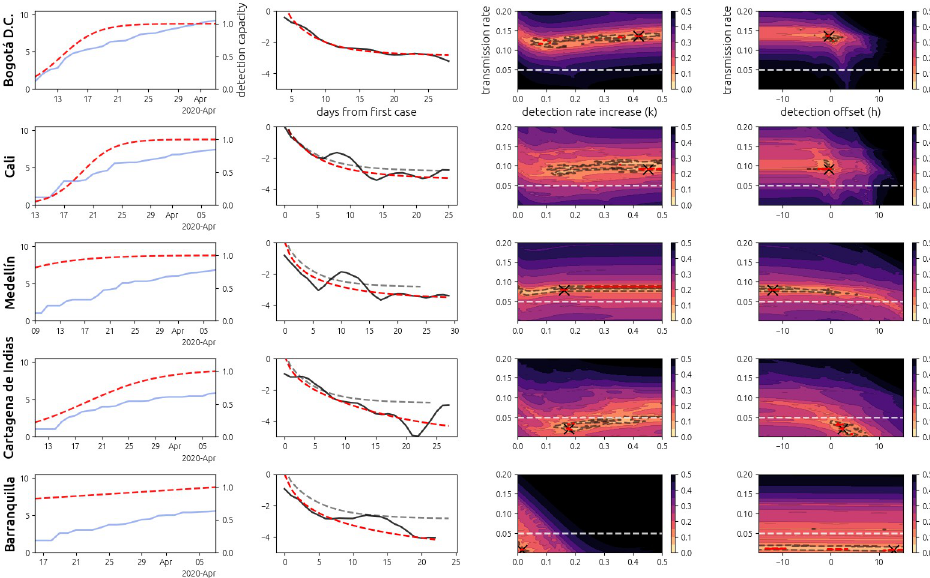
Fig 3. COVID-19 and model fit in the five largest cities of Colombia. Each row corresponds to a different city (left axis). The first column plots the cumulative number of confirmed cases of COVID-19 over the pre-quarantine period (blue) as well as the inferred detection capacity within the city (dashed red, right axis). The second column plots the log-velocity (see S1 File) of the data (black) and of the model fit (dashed red), with the model for Bogota´ D.C. shown for reference (dashed gray). The third and fourth columns show cross-sections of the error function e ( r , k , h ) between the model under parameters ( r , k , h ) (transmission rate, detection rate increase rate, and detection rate half capacity date). The error bars are given in terms of percent increase from the global minimum. Global minima are denoted by a black cross. The dashed white line indicates the threshold r = 0.05 for observing clear exponential growth in our model. The red contours denote an increase from the global minimum of 5% and the gray contours denote an increase from the global minimum by 10%.